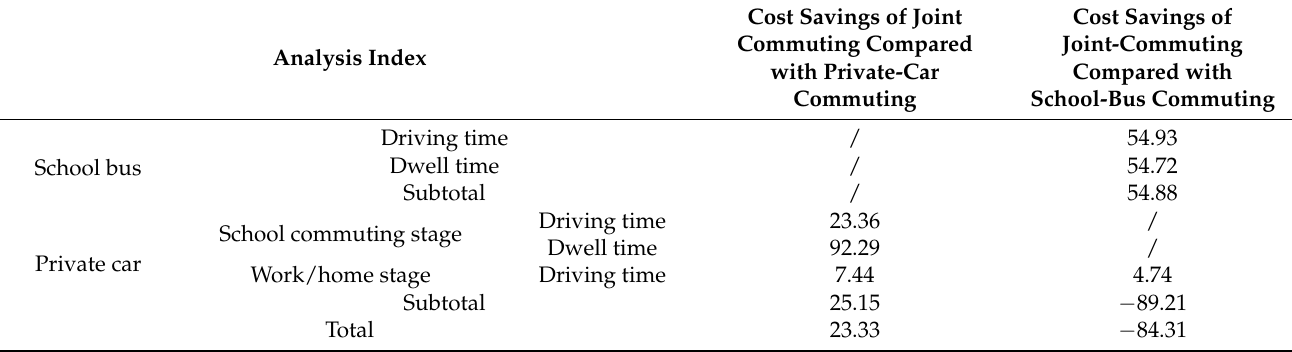
Table 6. Cost saving